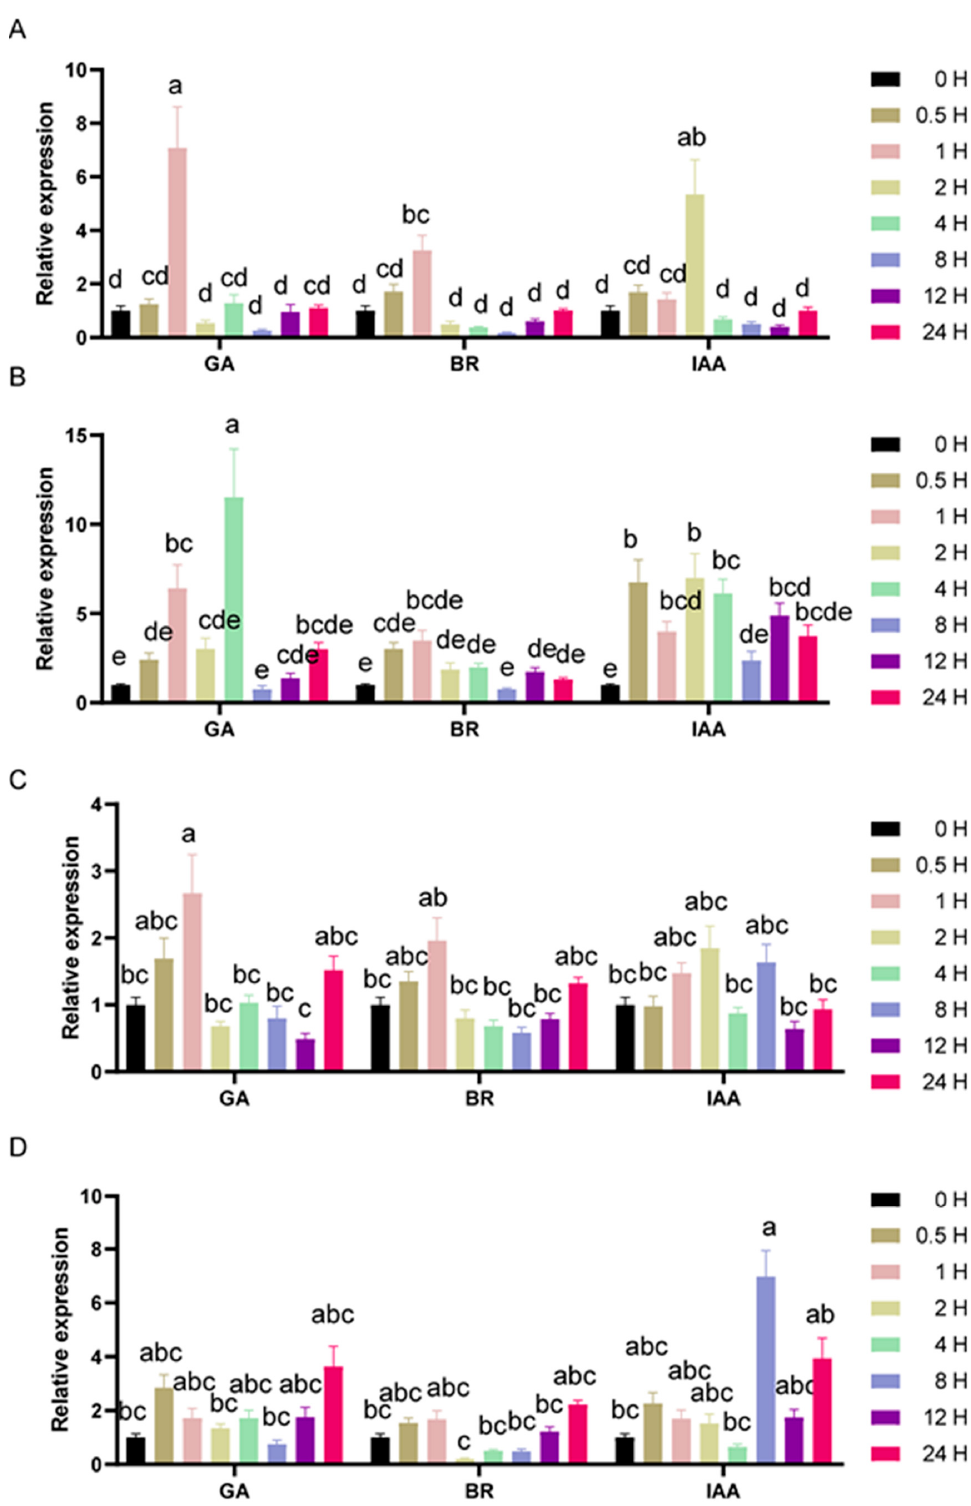
The expression levels of SlGIF1b and SlGIF2 were downregulated sharply after the peak at 4 and 1 h under the GA treatment, respectively. This suggested different roles of SlGIFs in growth signals.